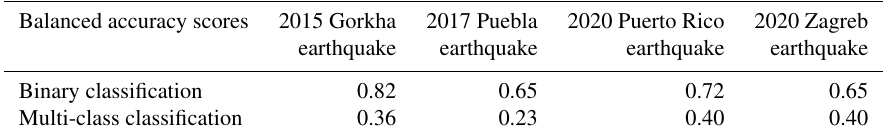
Table 10. Summary of balanced accuracy scores for multi-class and binary